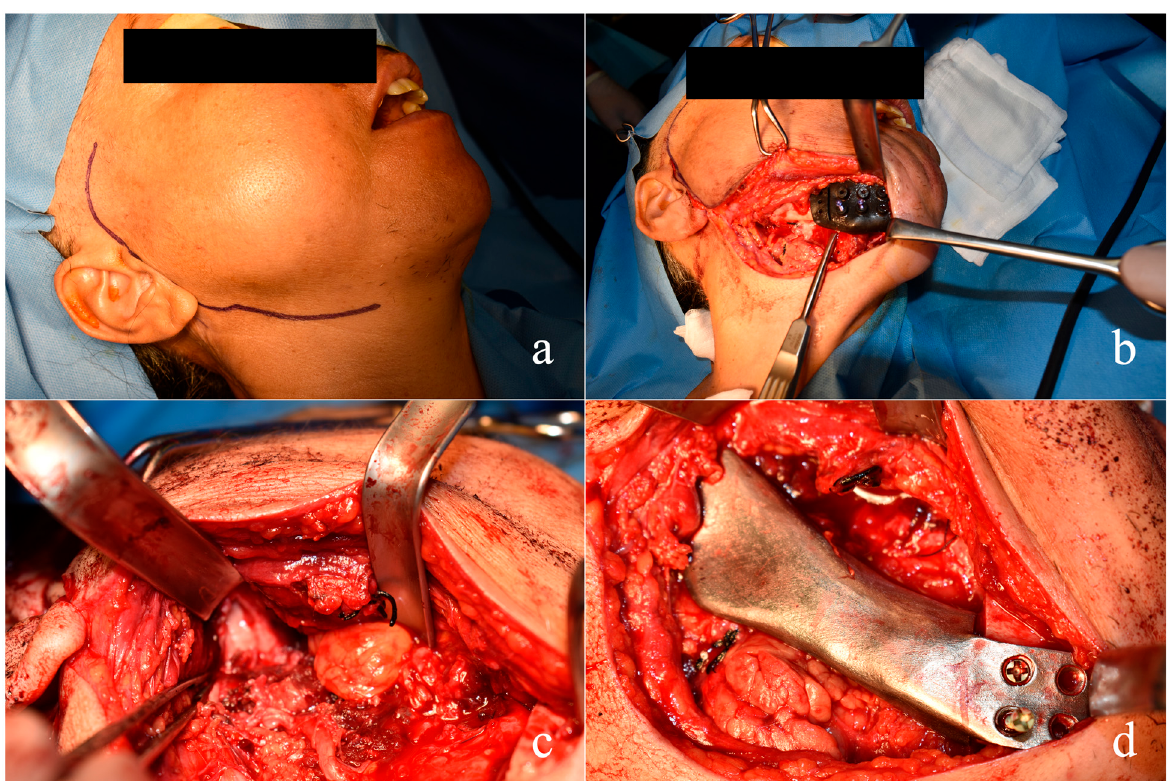
Figure 7. Intra-operative sequence: ( a ) intra-operative view: trans-cutaneous access in the subman- dibular area. ( b ) Positioning of the custom-made surgical guide. ( c ) Preservation of the articular disc. ( d ) Positioning of the custom-made mandibular prosthesis.